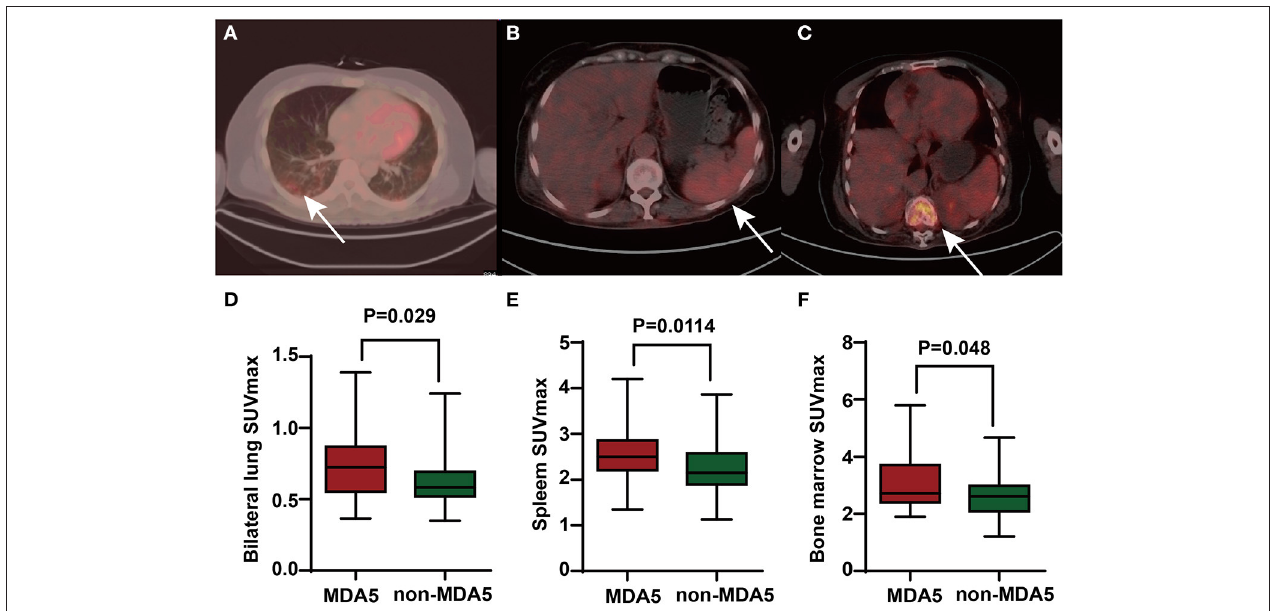
FIGURE 3 | The PET/CT images of anti-MDA5 + DM patients and comparison of FDG uptake between anti-MDA5 + group and anti-MDA5– group. (A) Elevated FDG uptake of lungs (where the arrow pointed). (B) Elevated FDG uptake of spleen (where the arrow pointed). (C) Elevated FDG uptake of bone marrow (where the arrow pointed). (D) Comparison of bilateral lung SUVmax between the anti-MDA5 + group and anti-MDA5– group. (E) Comparison of spleen SUVmax between the anti-MDA5 + group and anti-MDA5– group. (F) Comparison of bone marrow SUVmax between the anti-MDA5 + group and anti-MDA5– group. SUVmax, maximum standardized uptake value; MDA5, melanoma differentiation associated protein 5; DM, dermatomyositis; FDG, 18